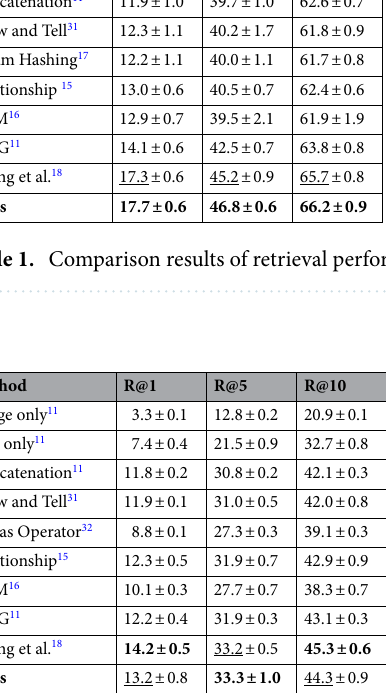
Table 2. Comparison results of retrieval performance on MIT-States